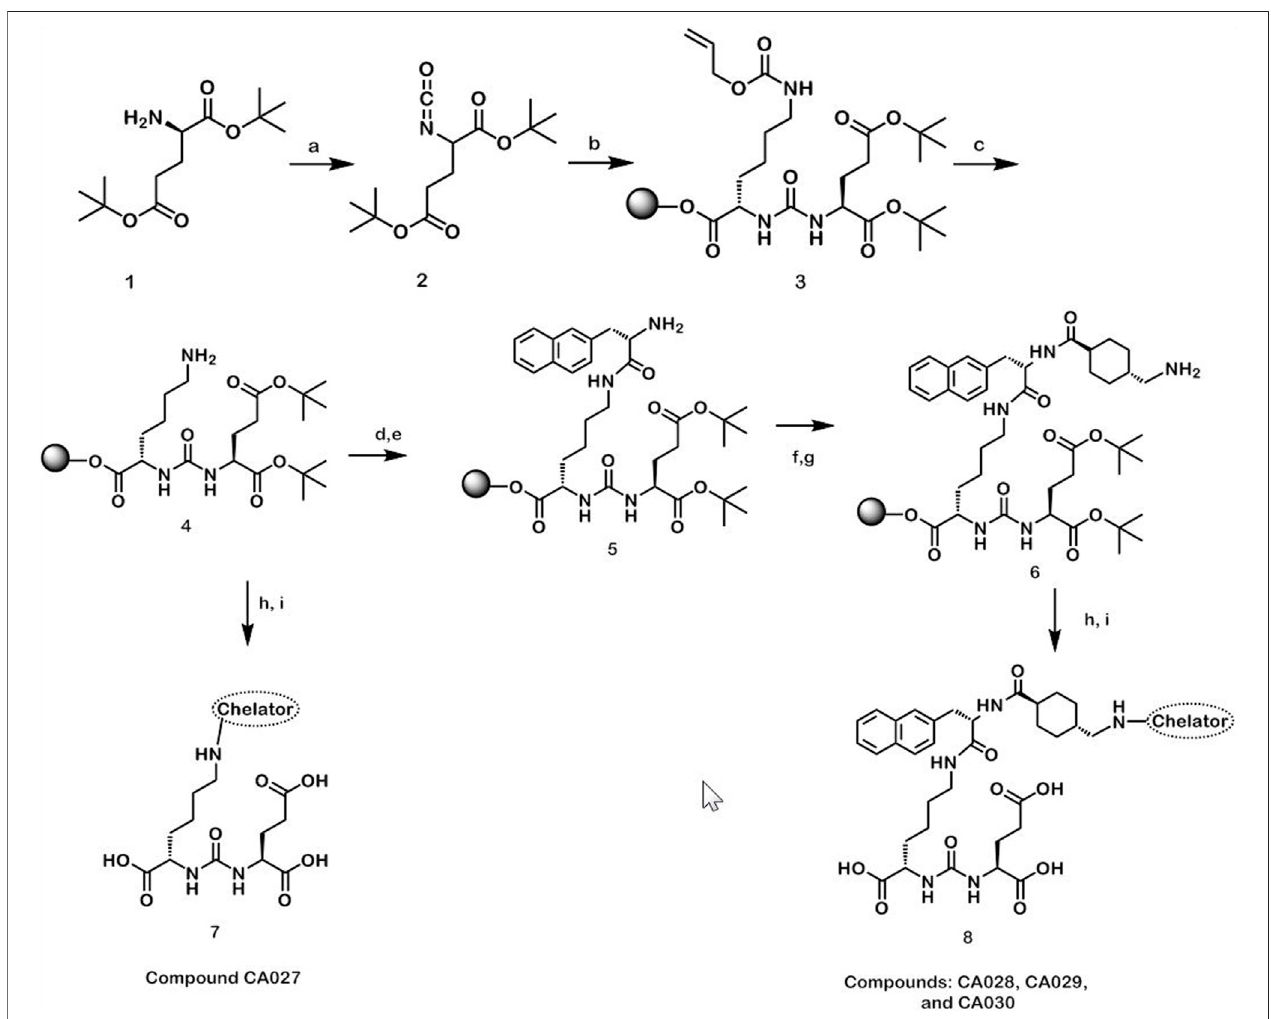
FIGURE 2 | Reaction scheme for the synthesis of the novel PSMA ligands (A) triphosgene, diisopropylethylamine, dichloromethane, 0 ° C; (B) H-Lys (Alloc)-2CT- resin, dichloromethane; (C) Pd[P(C 6 H 5 ) 3 ] 4 , morpholine, dichloromethane; (D) Fmoc-2-Nal-OH, HBTU, diisopropylethylamine,DMF; (E) 50%piperidine, DMF; (F) trans- 4-(Fmoc-aminomethyl)cyclohexanecarboxylic acid, ethyl-cyano (hydroxyimino)acetate, DIC, DMF; (G) 50% piperidine, DMF; (H) chelator, diisopropylethylamine, DMF; (I) 95% TFA, 2.5% triisopropylsilane and 2.5% H 2